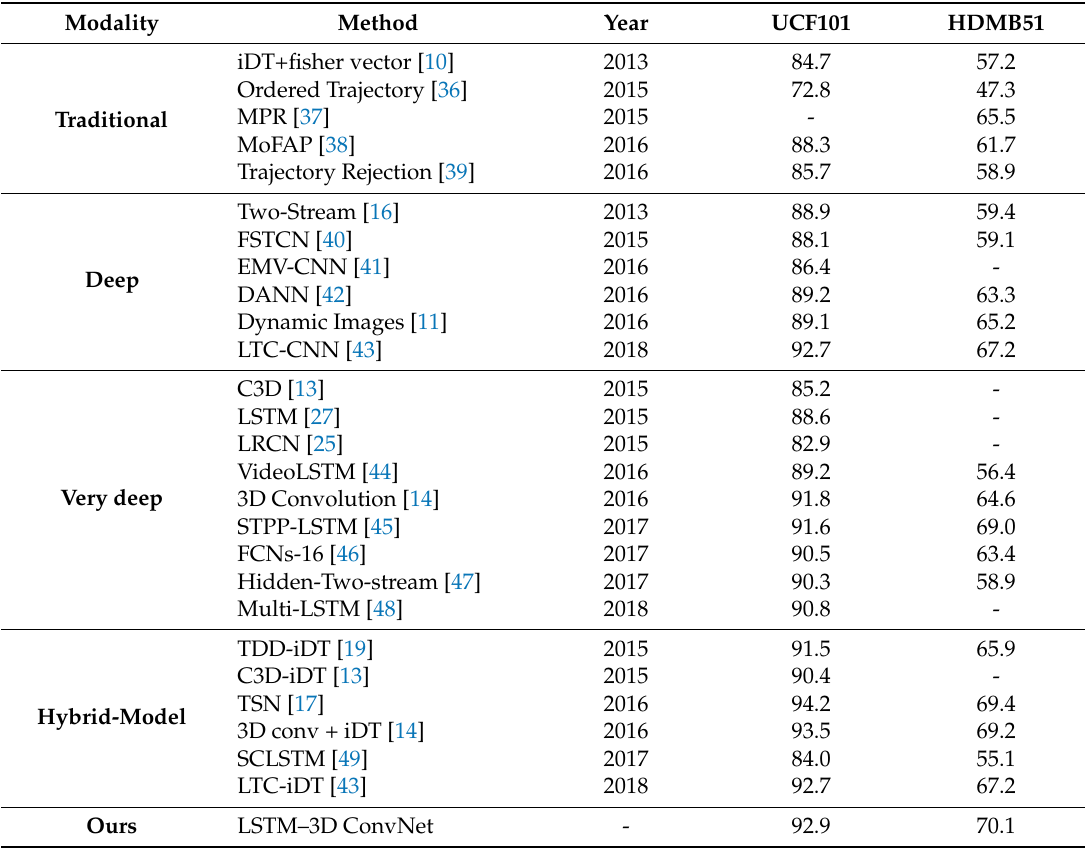
Table 4. Comparison to the state-of-the-art